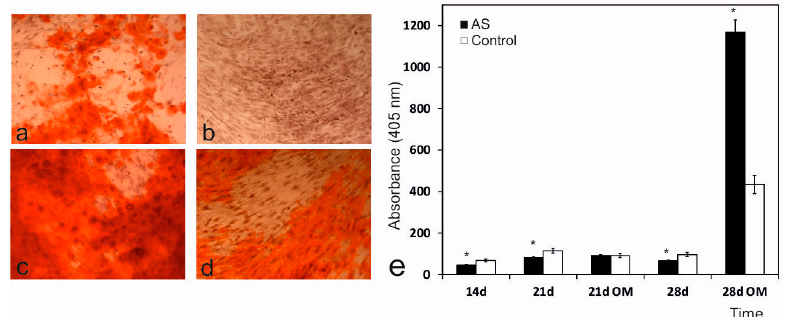
Figure 6. Alizarin Red staining and the activity analysis of the ahMSCs seeded on plastic and the AS ceramic on day 28. The Alizarin Red expression of the ahMSCs seeded on plastic ( a , b ) and AS ceramic ( c , d ) in either OM ( a , c ) or GM ( b , d ) (×100). ( e ) The quantitative ALP activity of the ahMSCs seeded on plastic and the AS ceramic was measured on days 14, 21 and 28 in GM and on days 21 and 28 in OM. * indicates significant differences, p < 0.05.